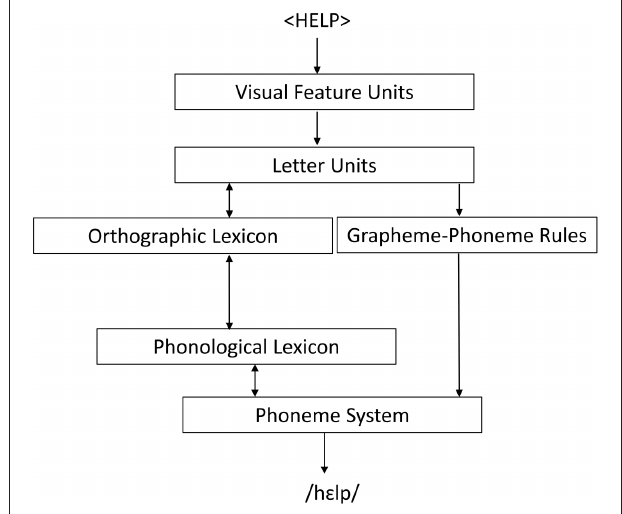
FIGURE 1 | The Dual-Route Cascaded Model (DRC); see Coltheart et al. (2001: